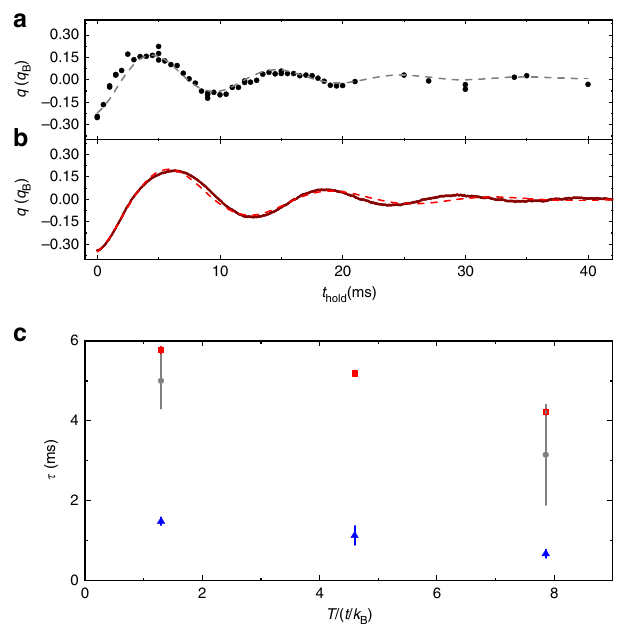
Fig. 6 Dephasing of motion for a non-interacting gas in an s = 4 lattice. a Measured average quasimomentum q along the impulse direction for a spin-polarized (non-interacting) gas. For these data, N ≈ 42,000 and T / T ≈ 0.25 in the trap before turning on the lattice. The line is a fi t used to F determine the dephasing time. b Simulated average quasimomentum q along the impulse direction for a non-interacting gas. For this simulation, ~ T ¼ 1 : 3 t = k ð Þ = 3 and ~ μ ¼ 4 : 5 t = 3 in the lattice. The deviation of the fi t at long B times is a result of the anharmonicity of the lattice gas, which is not accounted for in the fi t. c Comparison of dephasing and transport lifetime τ at different temperatures. The dephasing time measured using a spin- polarized gas are shown using red circles, and the measured transport lifetime for a spin-mixed gas is shown using blue triangles. The simulated dephasing time is plotted using gray squares. For the simulated time, the temperature is three times smaller than the value on the abscissa. The chemical potentials used in the simulation are 4.5 t /3, − 4.5 t /3, and − 18.2 t /3. The error bars represent the uncertainty in the fi t used